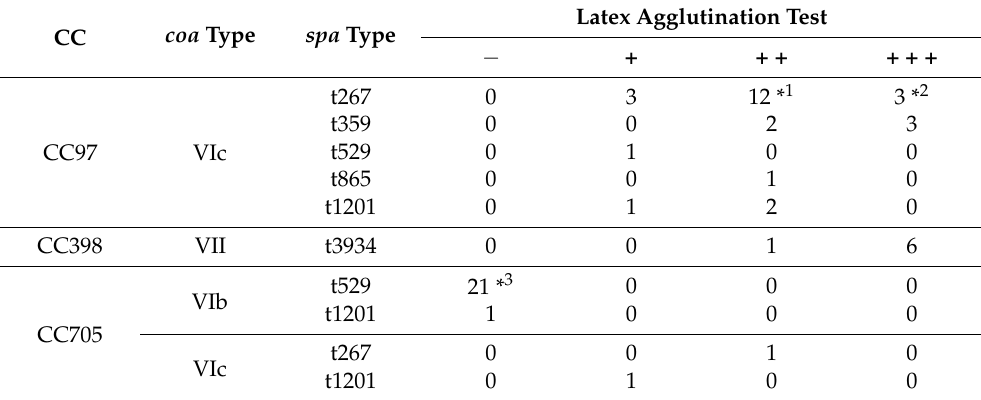
Table 4. Prevalence data of genetic typing (CC, coa , and spa ) and latex